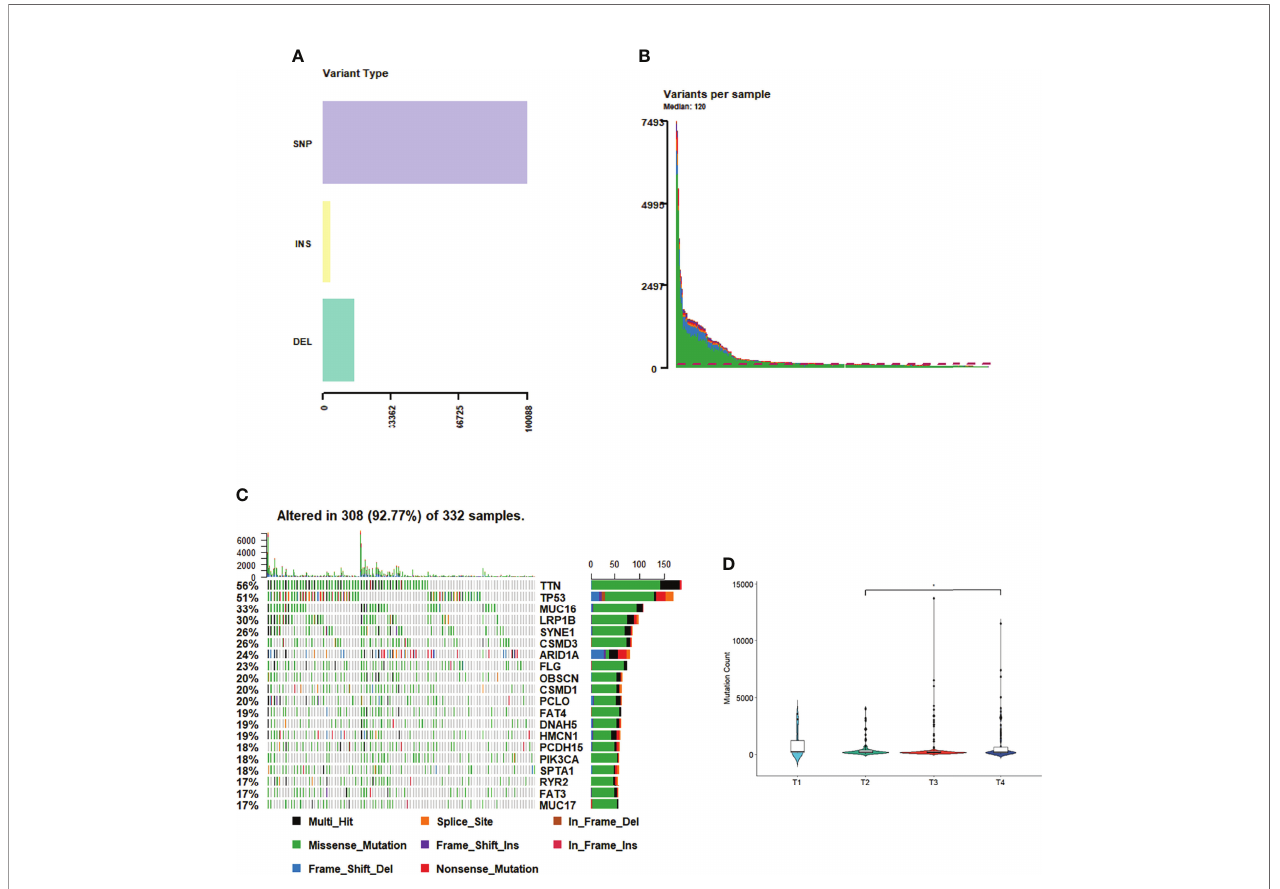
FIGURE 1 | Tumor mutation pro fi le. (A) Variant type of GC. (B) Variants in each sample. (C) The most mutations in GC. (D) The number of mutations in T phases of